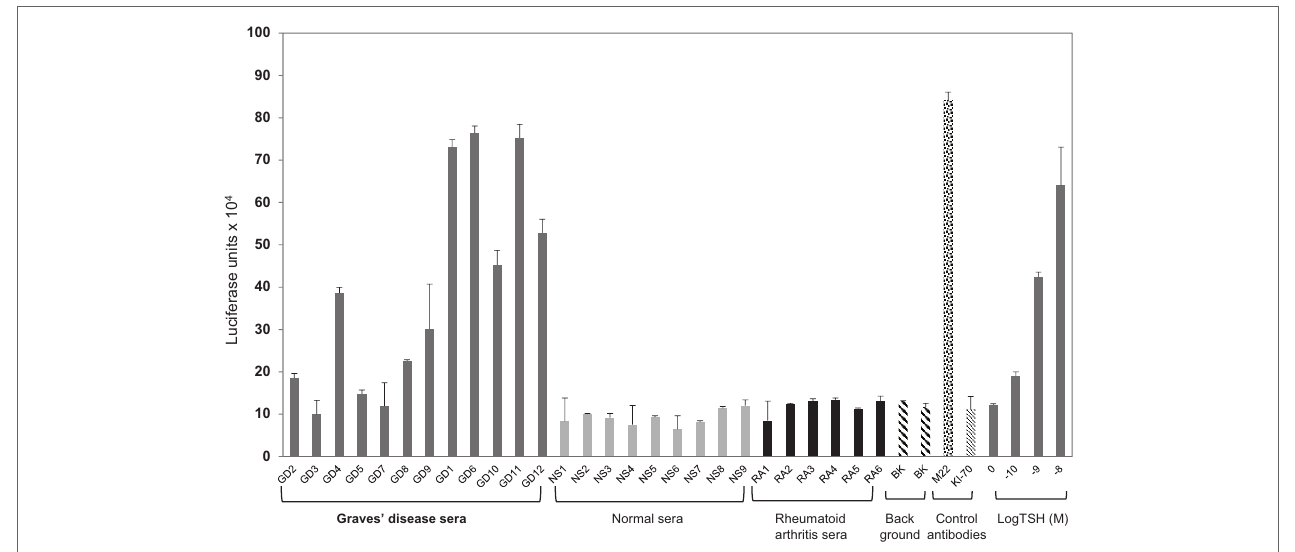
FIGURe 5 | Agonist activity measured in patient sera using tshR-Glo. Graves’ disease patient and normal sera were diluted 1:5 in medium. Ten of the 12 GD (Graves’ disease) serum samples (denoted GD with dark gray bars) stimulated the production of cAMP in contrast to no stimulation observed with any of the normal (denoted NS with light gray bars) or rheumatoid arthritis (denoted RA with black bars) patient sera. Background is denoted by the two filled hatched bars, a human-stimulating monoclonal antibody (M22 shown as hatched bar), human-blocking monoclonal antibody (K1-70 shown as filled criss-cross bar) 1 μ g/ml, and bovine TSH (gray bars) at increasing log